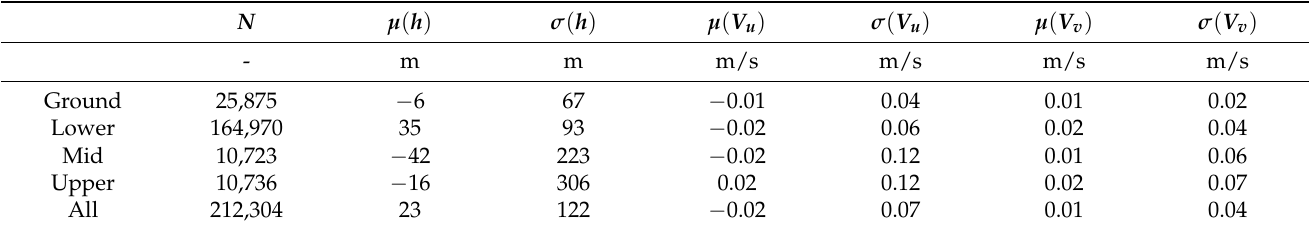
Table 2. Retrieval Consistency Statistics. Note: GOES-18 Preliminary, Non-Operational Data